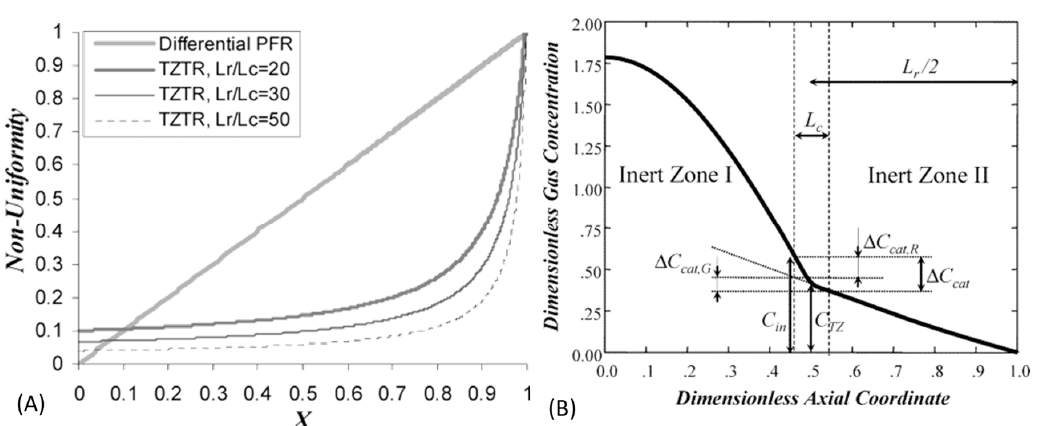
Figure 4. ( A ) Gas concentration nonuniformity versus conversion for the differential plug flow reactor (PFR) and thin-zone TAP reactor at different values of the geometric parameter L r / L c where L c is the length of the catalyst zone, L r is the length of the whole TAP reactor and X is conversion; ( B ) thin-zone concentration profile with dashed lines indicating nonuniformity in the catalyst zone; reprinted with permission from Shekhtman et al. [30] Copyright 2005 American Chemical Society.